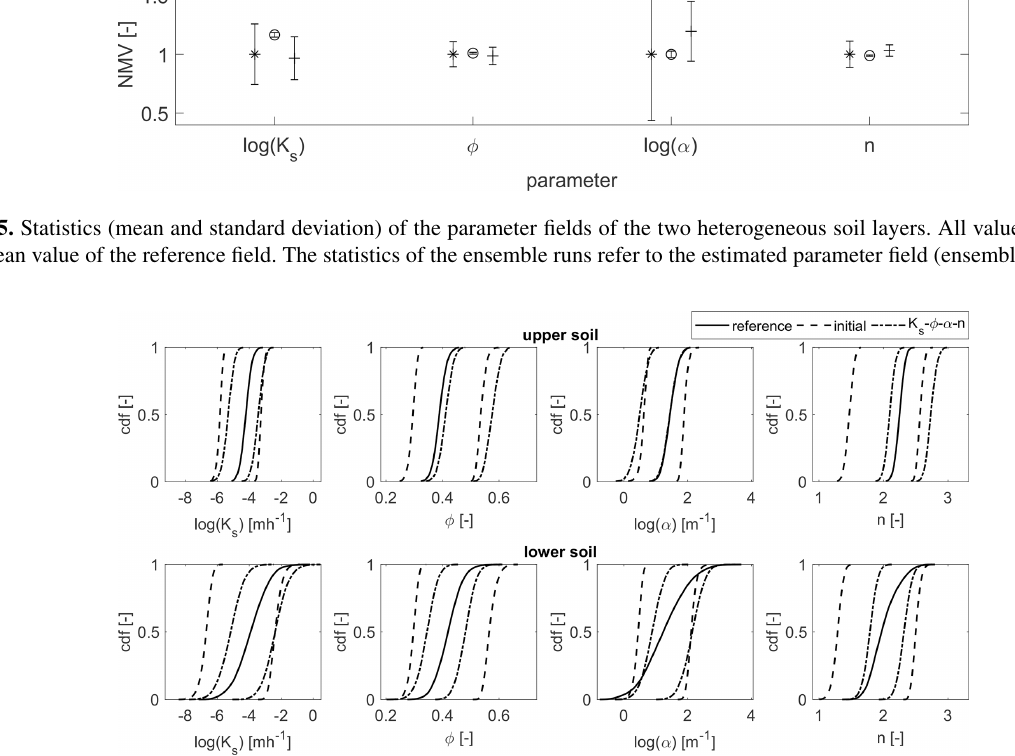
Figure 16. Cumulative density functions (cdf’s) of the parameter values for the two heterogeneous soil layers. The solid line denotes the cdf of the reference parameter field. For the initial (dashed) and estimated (dash-dotted) ensemble, two lines are plotted to indicate the minimum and the maximum values of the